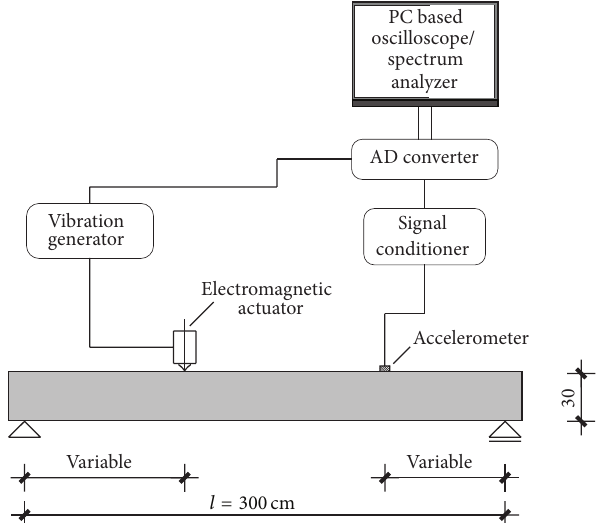
Figure 4: Experimental setup for natural frequency